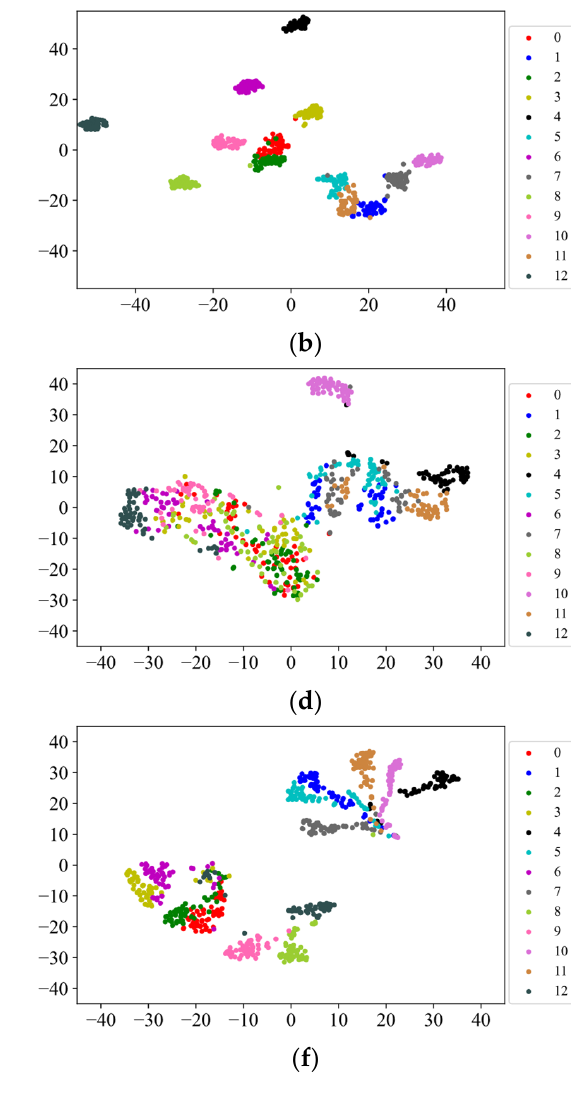
Table 7. Comparison of diagnostic results on dataset 3 under 3 samples per class.